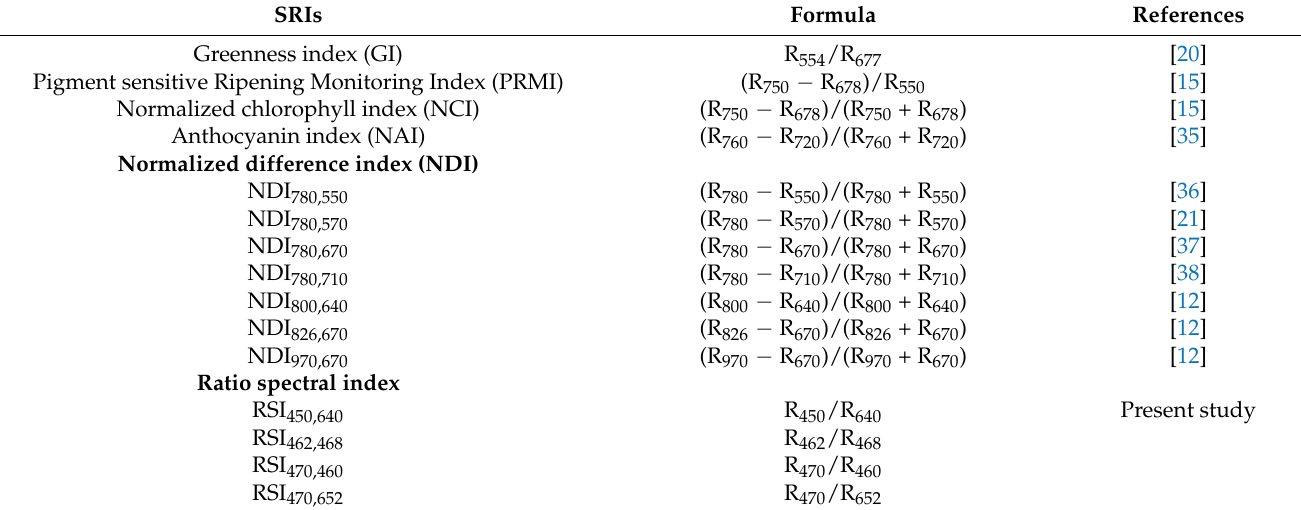
Table 1. Description of the published in the literature and newly developed (SRIs) examined in this study. SRIs